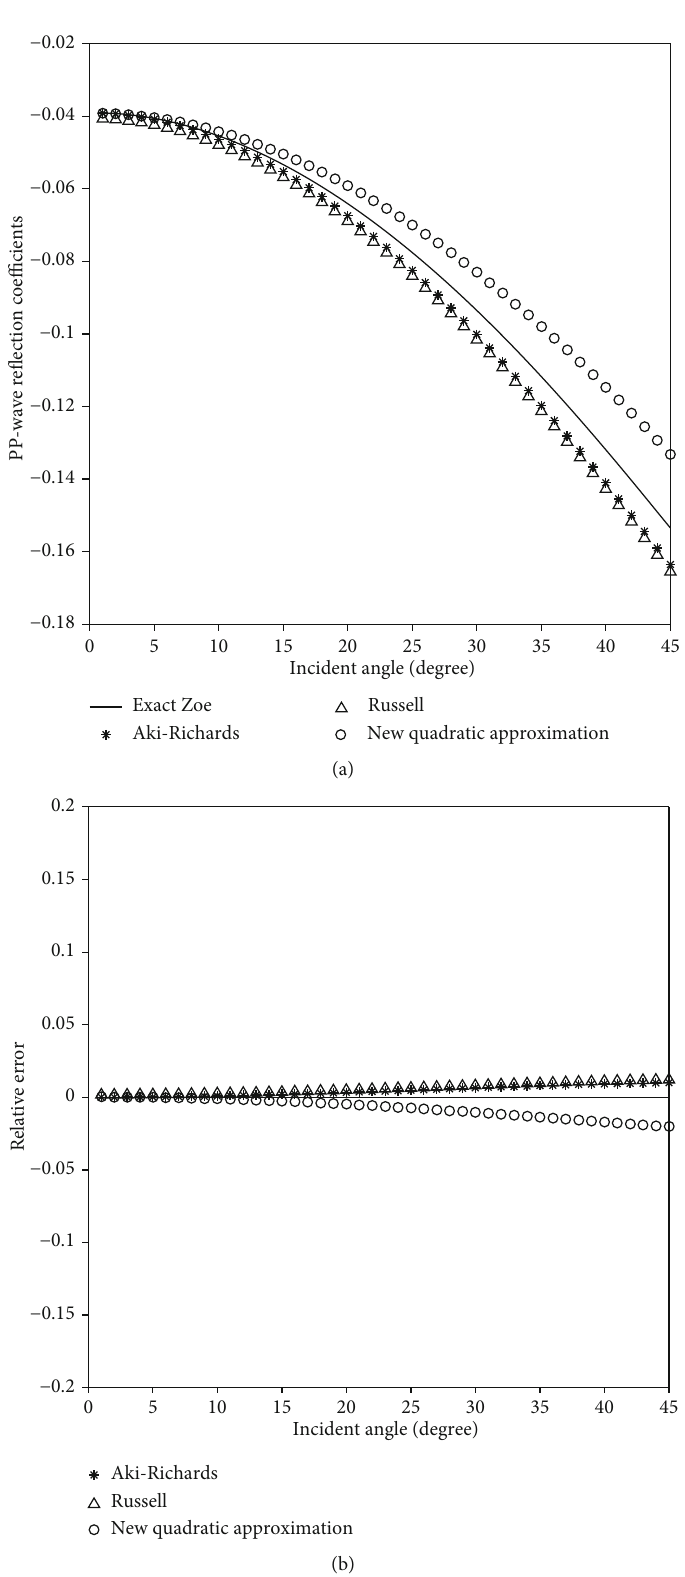
Figure 2: Comparison of re fl ection coe ffi cients calculated by the exact Zoeppritz equations, Aki – Richards approximation, Russell linear approximation, and the new quadratic approximation of model 2. (a) Re fl ection coe ffi cients calculated by di ff erent formulas; (b) di ff erence of the re fl ection coe ffi cients between the exact Zoeppritz equations and their three approximations,